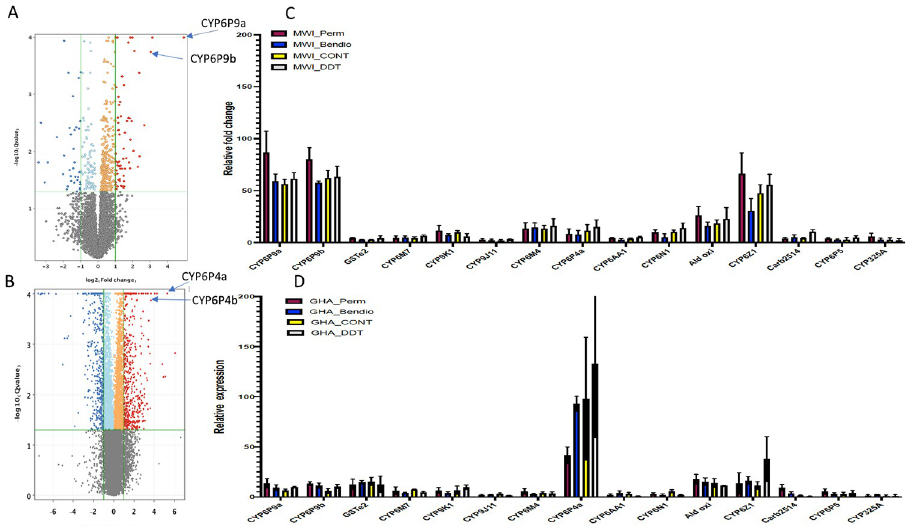
Fig 1. Transcription profiling of bendiocarb resistance. A) Volcano plot of differential gene expression between bendiocarb-exposed samples from Malawi and FANG showing the high over-expression from CYP6P9a and -b . B) Volcano plot of differential gene expression between bendiocarb-exposed samples from Ghana and FANG showing the high over-expression from CYP6P4a and - b . C) qRT-PCR validation of the expression profile of the main detoxification genes differentially expressed between resistant and susceptible bendiocarb samples with RNAseq in Malawi; MWI; Malawi, Perm is permethrin, Bendio is bendiocarb. D) is for